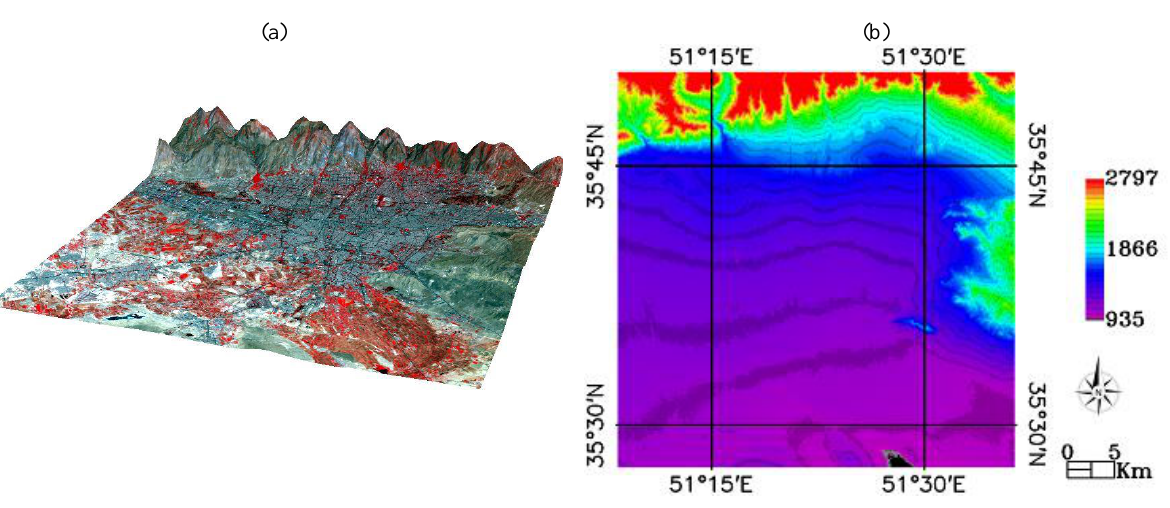
Tehran and three-dimensional view of TM false color combination using SRTM data.